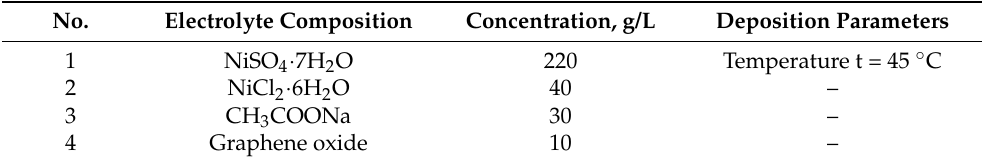
Table 1. Electrolyte bath composition and deposition parameters used for nickel–GO composite